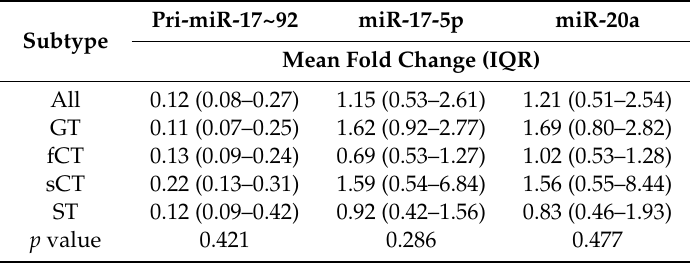
Table 4. Distribution of Pri-miR-17~92 and mature microRNAs expression (fold change) according to PitNET